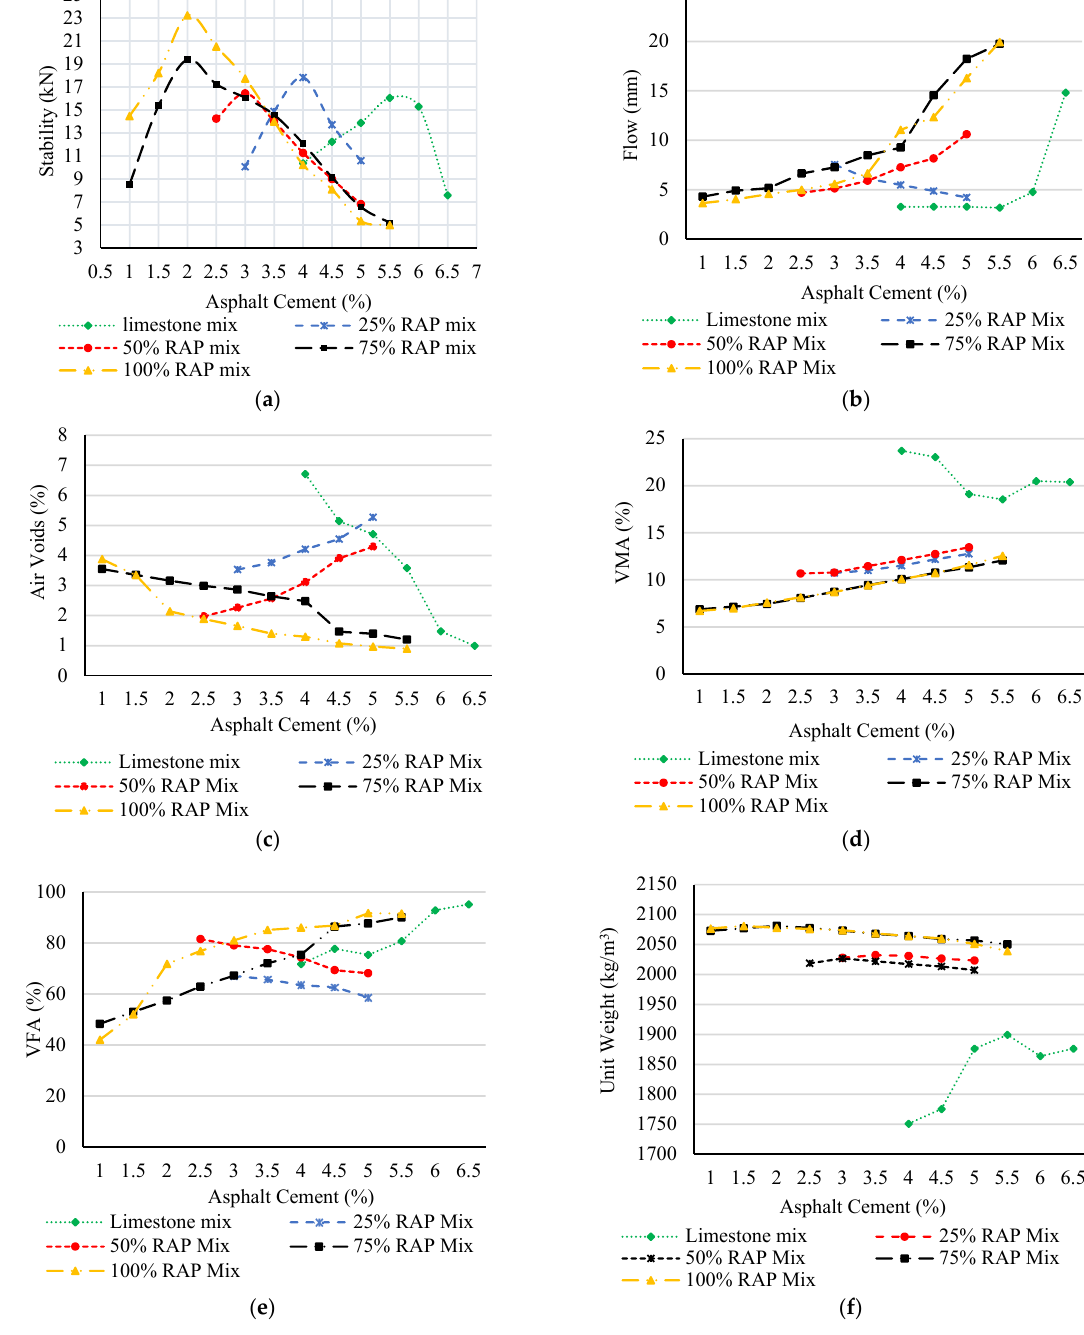
Figure 4. Test results of the asphalt mixes containing RAP in terms of ( a ) Marshall stability; ( b ) flow; ( c ) unit weight; ( d ) air voids; ( e ) VMA; ( f ) VFA. Table 4. Test results for the tested mix prepared with RAP aggregate.